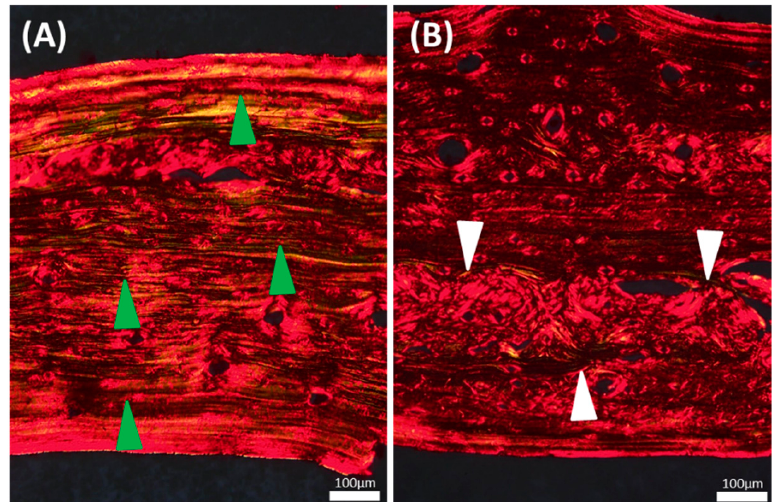
Figure 2. Characterization of collagen structure by the picrosirius red stain of calvaria in coronal cross-sections in which the bottom of the section is the meningeal side. Mature collagen fibers stain green/yellow, while immature collagen fibers stain red/orange. ( A ) Control group shows uniform collagen fibers running parallel to each other, as indicated by green arrowheads; ( B ) BAPN group shows fewer mature fibers and more immature collagen tissue as indicated by white arrowheads. Magnification, ×20.